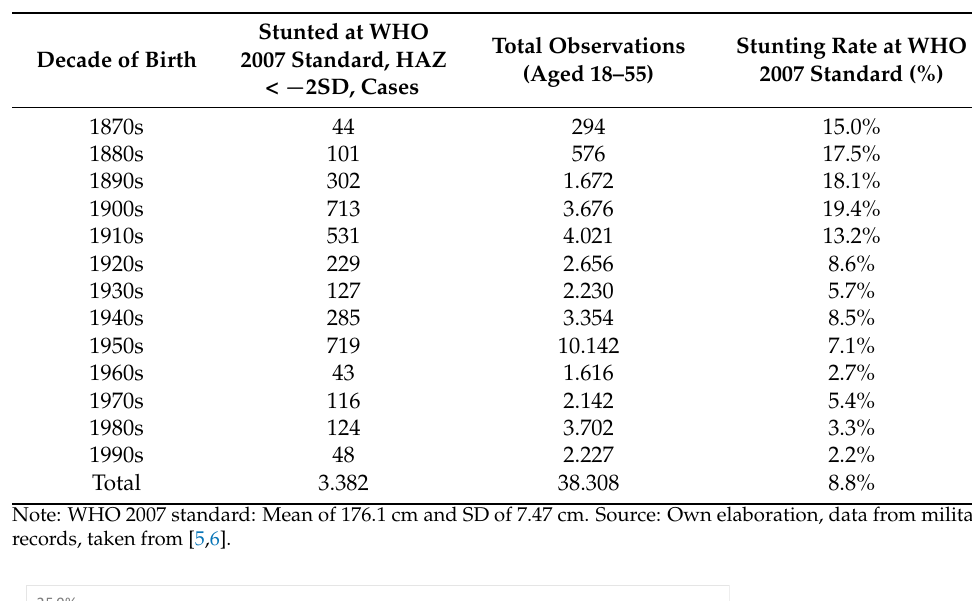
Table 1. Estimates of stunting rates in Chile, male adults born during the 1870–1990s.